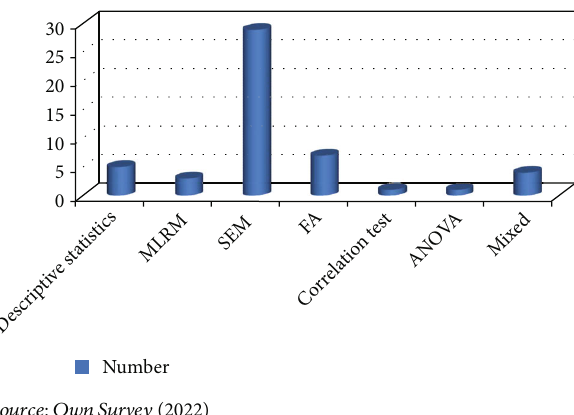
Figure 6: Data analysis methods employed by online consumer behavior studies.